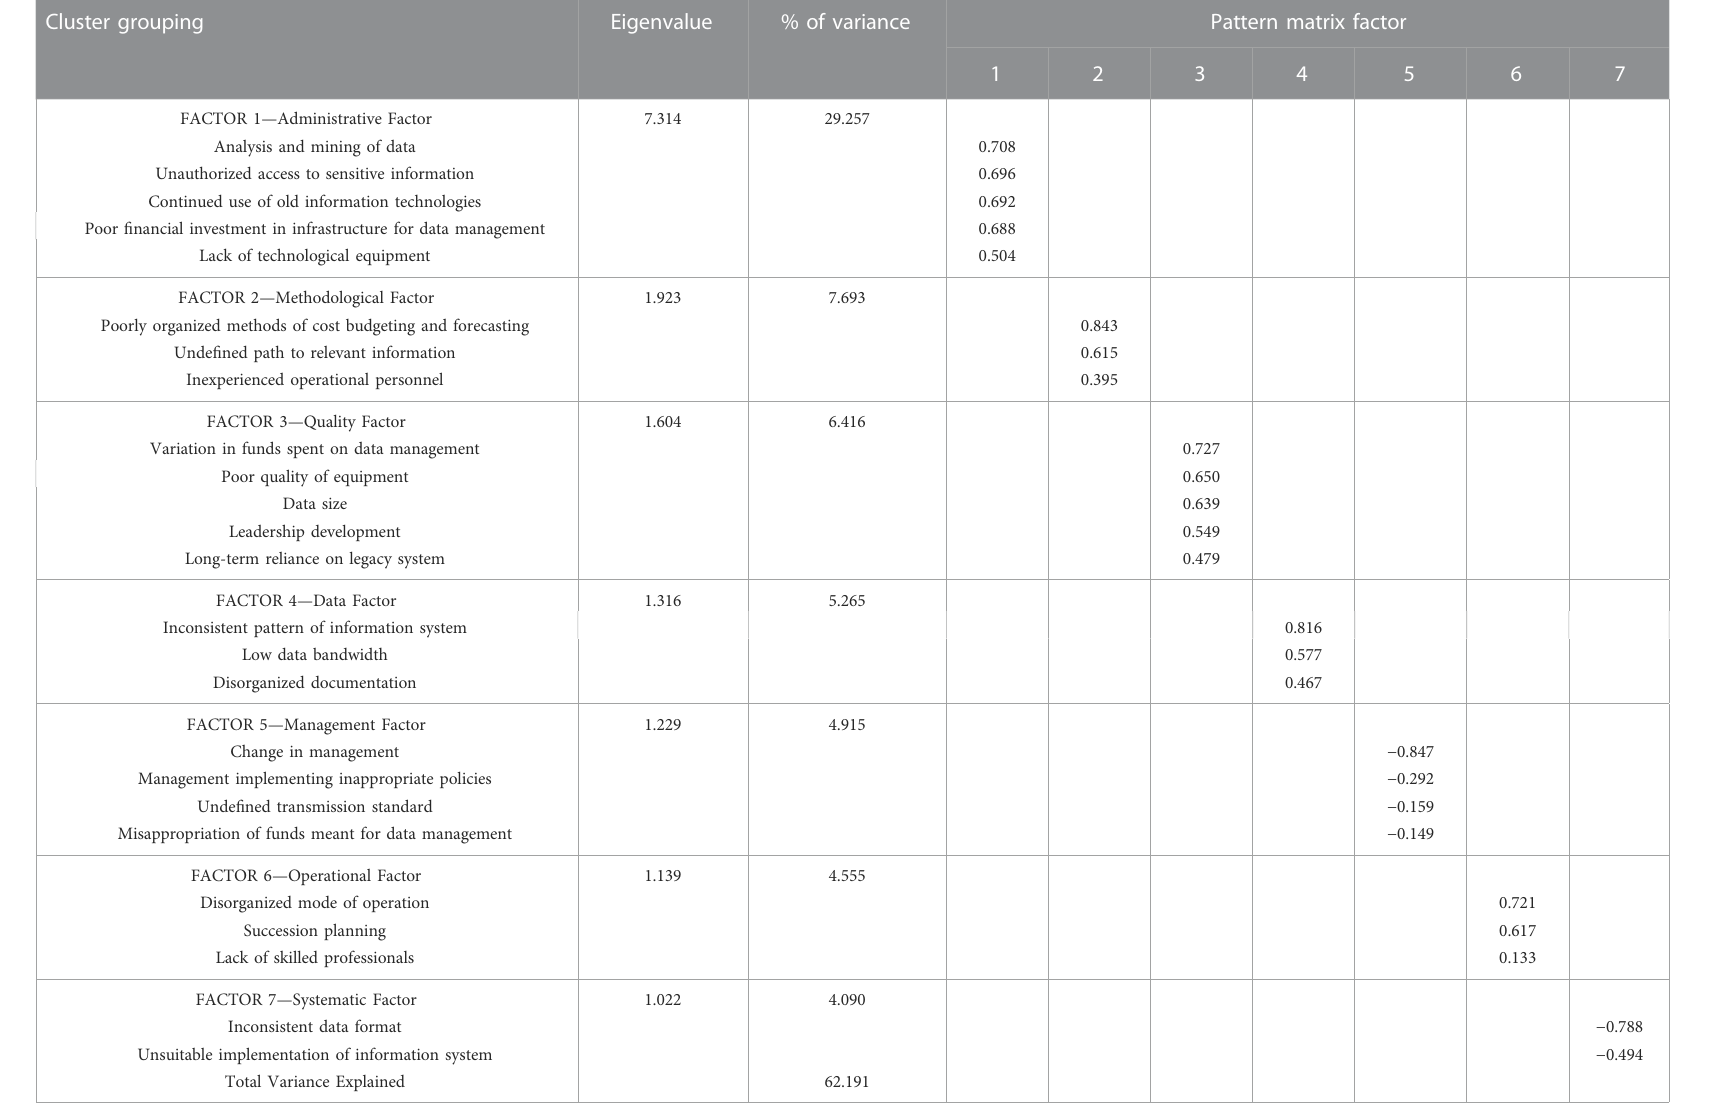
TABLE 3 Cluster groupings for Challenges in Construction Information Management. Cluster